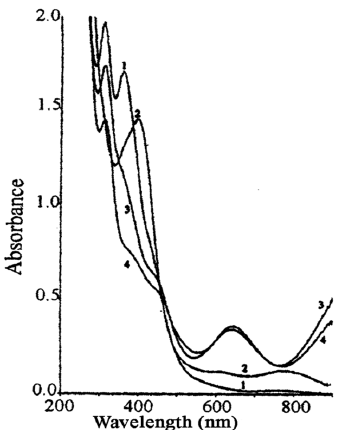
Figure 20. The effects of sodium dithionite on the absorption spectra of B-DNIC (0.47 mM as calculated per one iron atom) (pH 7.4) and M-DNIC (0.48 mM) (pH 10.7). Lines 1 and 2—The original absorption spectra of B- and M-DNIC, respectively. Lines 3 and 4—The absorption spectra of B- and M-DNIC treated with sodium dithionite under anaerobic conditions. B-DMIC were obtained by treatment of Fe 2+ and glutathione solutions with gaseous NO at pH 7.4 at the Fe 2+ : glutathione ratio of 1:10, M-DNIC—with pH increase of the latter solution to pH 10.7 [100]. (With permission). For both types of DNICs, the same EPR signals with g ⊥ = 2.01 and g = 1.97 at 77 K, and singlet signals at g = 2.0 at room temperature were registered (Figure 21): B-DNIC-GSH was synthesized with the ratio Fe 2+ : GSH = 1: 10 at pH 7.4, while M-DNIC-GSH were obtained by increasing pH of B-DNIC-GSH to 10.7. At the same time,